Question: Write a descriptive caption for this figure.
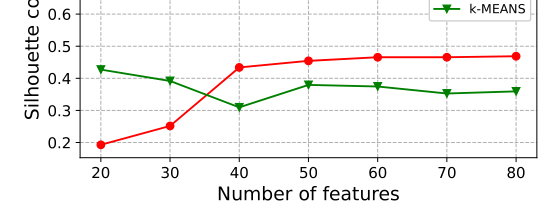
Answer: The relationship between the number of features and the silhouette coefficient.